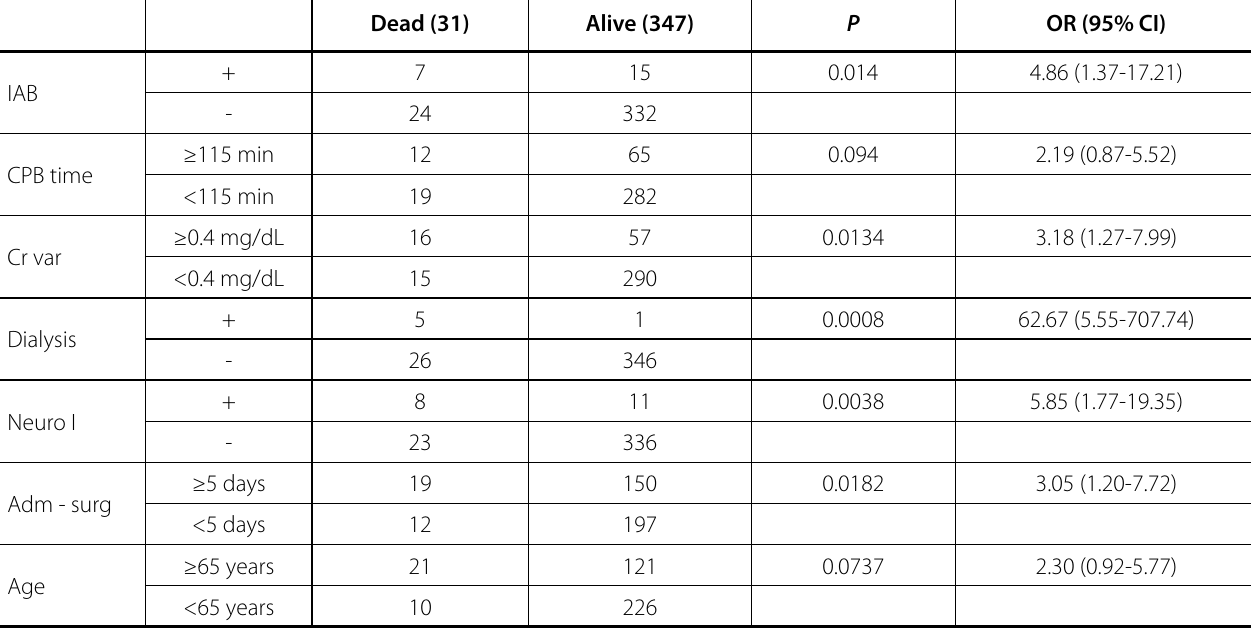
Table 3. Mortality risk factors among ONCABG patients (n=378) with admission creatinine levels greater than or equal to 1.2 and less than1.4 mg/dL (QIII).